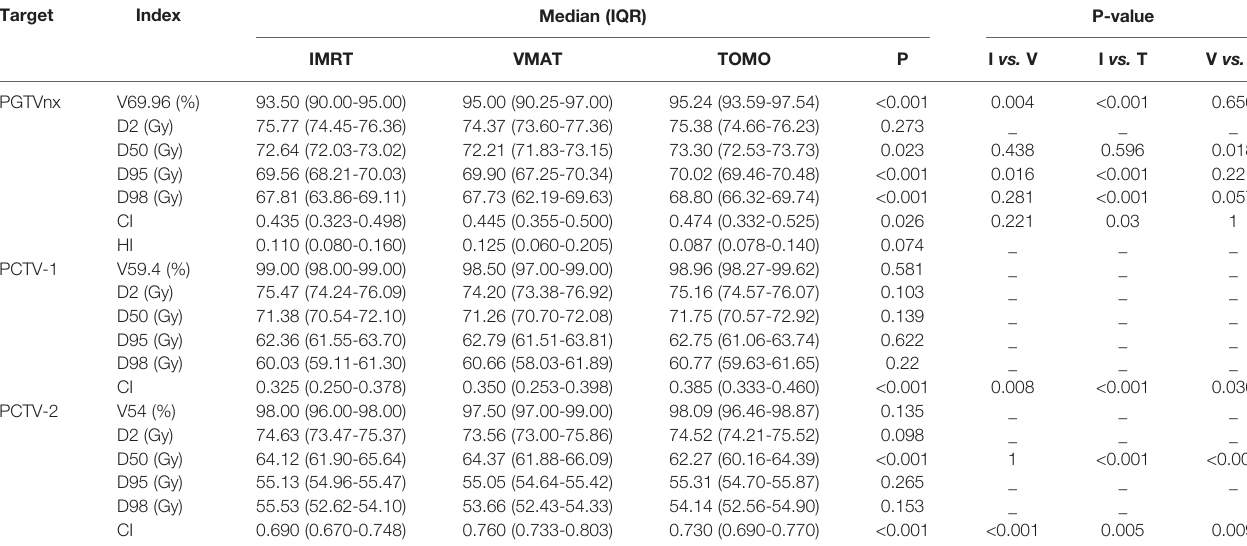
TABLE 2 | Dosimetric comparison of IMRT, VMAT and TOMO for PTVs in 40 NPC patients.